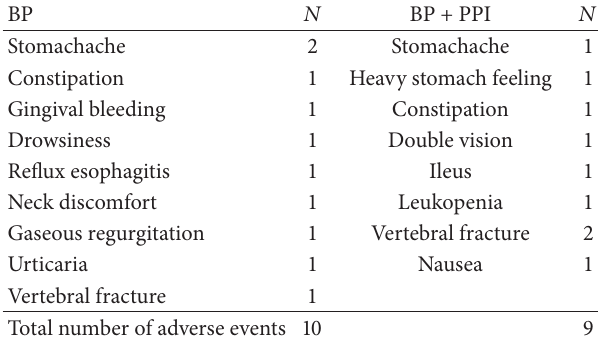
Table 1: Adverse events occurred under medical